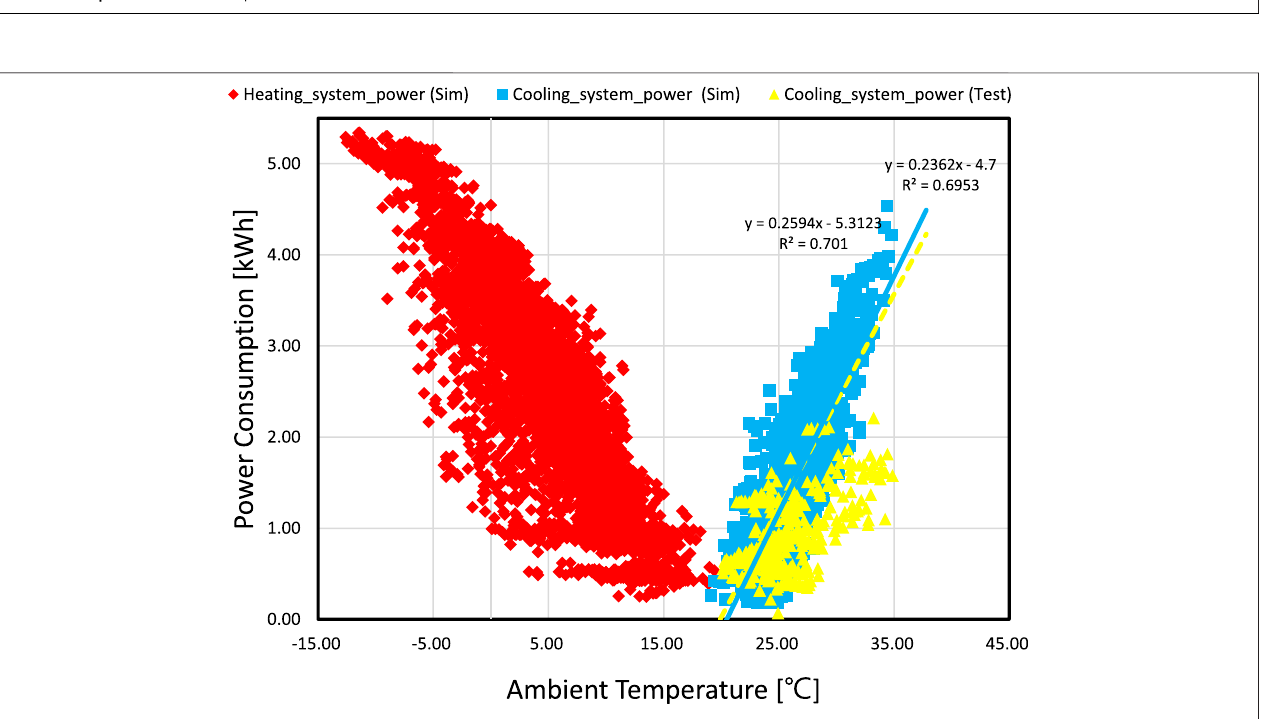
FIGURE 6 | Thermal load comparison.